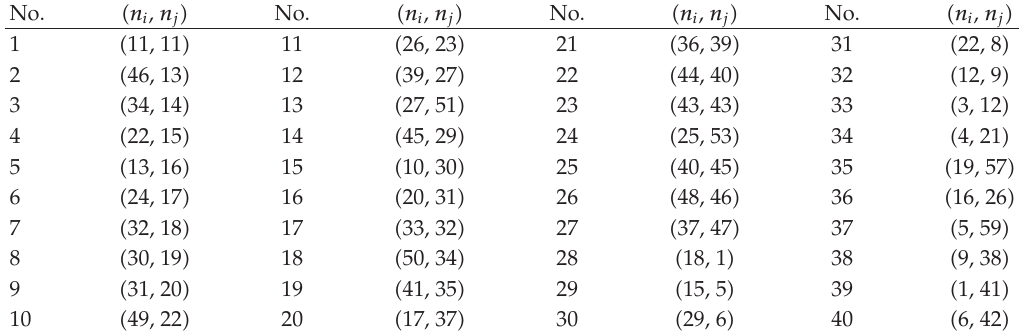
Table 3: Matched pairs (cid:6) n i , n j (cid:7) between Tables 1 and 2, where n i and n j are the serial numbers of points in Tables 1 and 2.